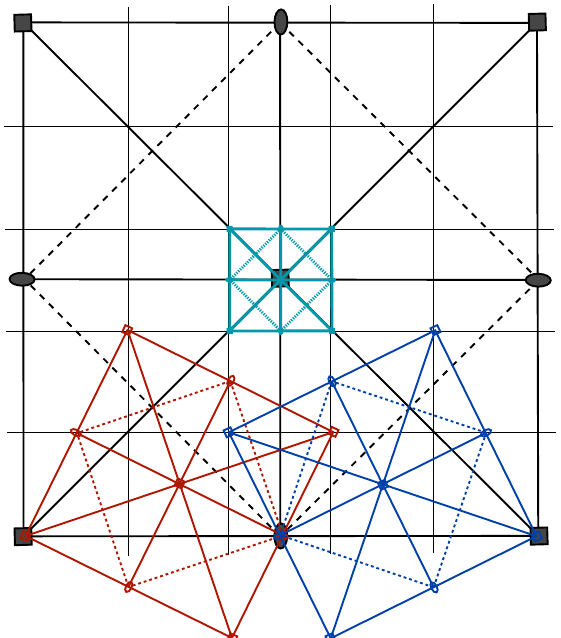
Figure 3. Example of two square crystals of space groups p 4 mm ( Λ ) rotated by α = 53.1301 ◦ , drawn in red and blue, leading to a coincidence lattice T 1 = ( 2,1 ) , T 2 = ( − 1,2 ) , Σ = 5, in black with same square symmetry p 4 mm ( T 1 , T 2 ) . The space group W α = p 4 mm ( U 1 , U 2 ) is shown in turquoise with U 1 = T 1 /5 and U 2 = T 2 /5. The number of various possible space groups of the (red-blue) bicrystals according to the value of the rigid-body translation are the number of position strata of p 4 mm ( U 1 , U 2 ) as given in Table